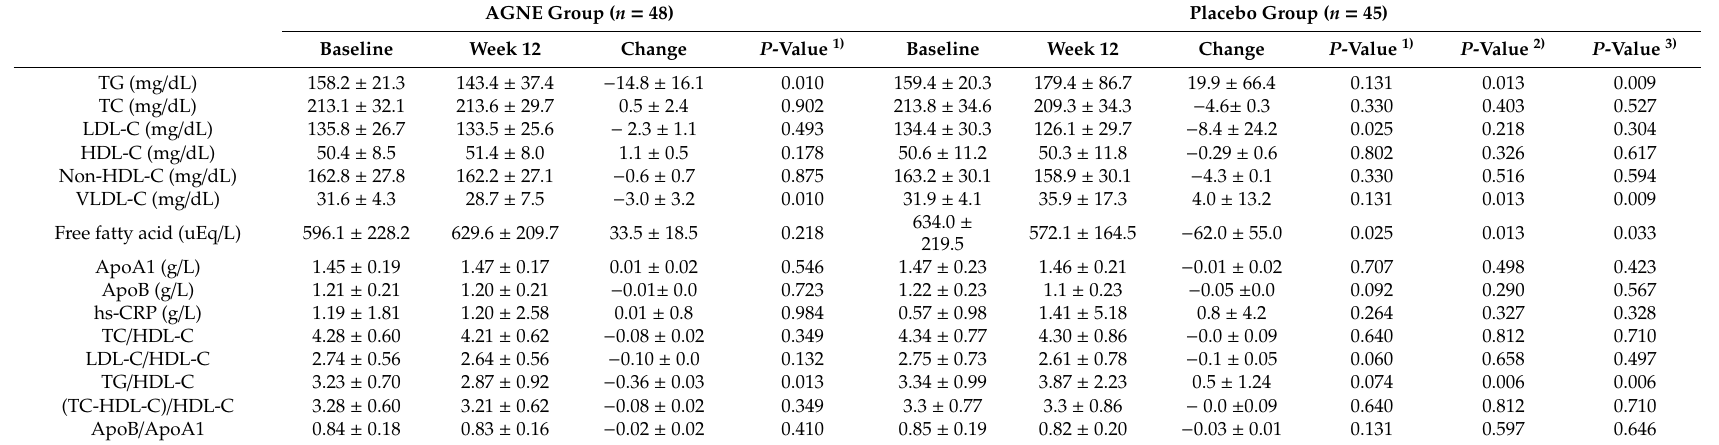
Table 4. Changes in blood triglycerides, lipid profile, high sensitivity C-reactive protein, and atherogenic